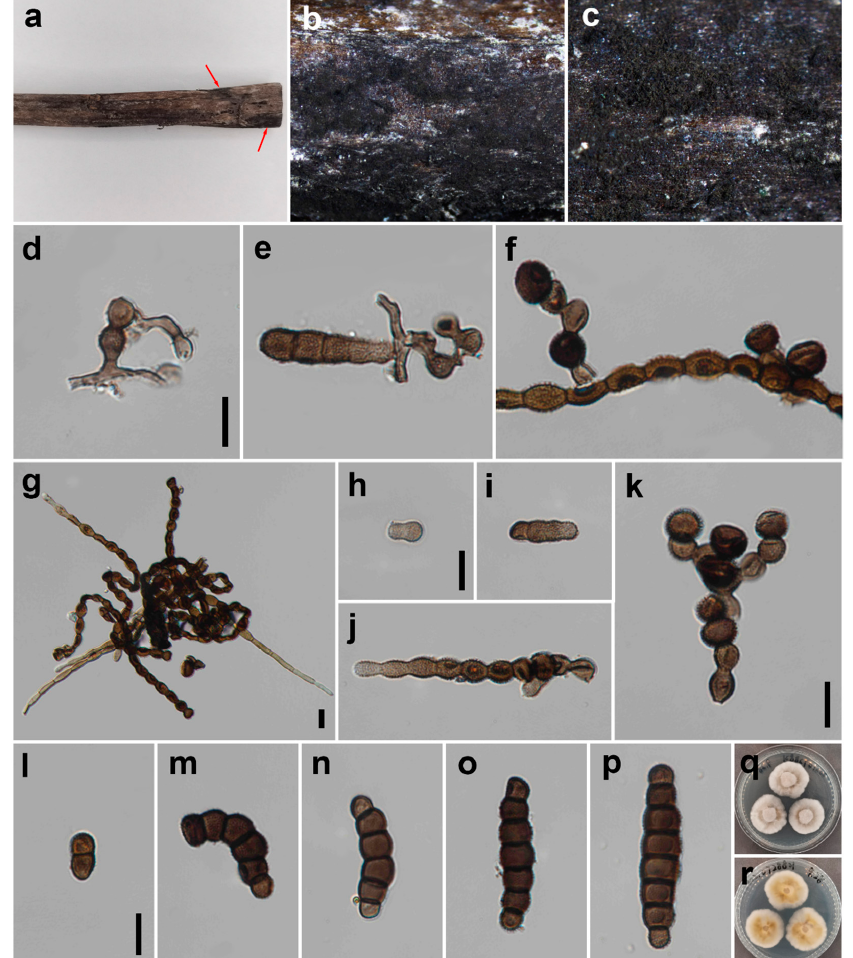
Figure 3. Torula longiconidiophora (HKAS 126512, holotype). ( a – c ) Colonies on the natural substrate; arrows indicate the locations of colonies. ( d – f ) Conidiophores with conidiogenous cells. ( g ) Mass of conidiophores. ( h – j ) Conidiophores. ( k ) Conidiogenous cells. ( l – p ) Conidia. ( q , r ) Culture on PDA from the surface and reverse. Scale bars: ( d – p ) = 10 µm. Scale bar of d applies to d – f . Scale bar of h applies to h – j . Scale bar of l applies to l – p .